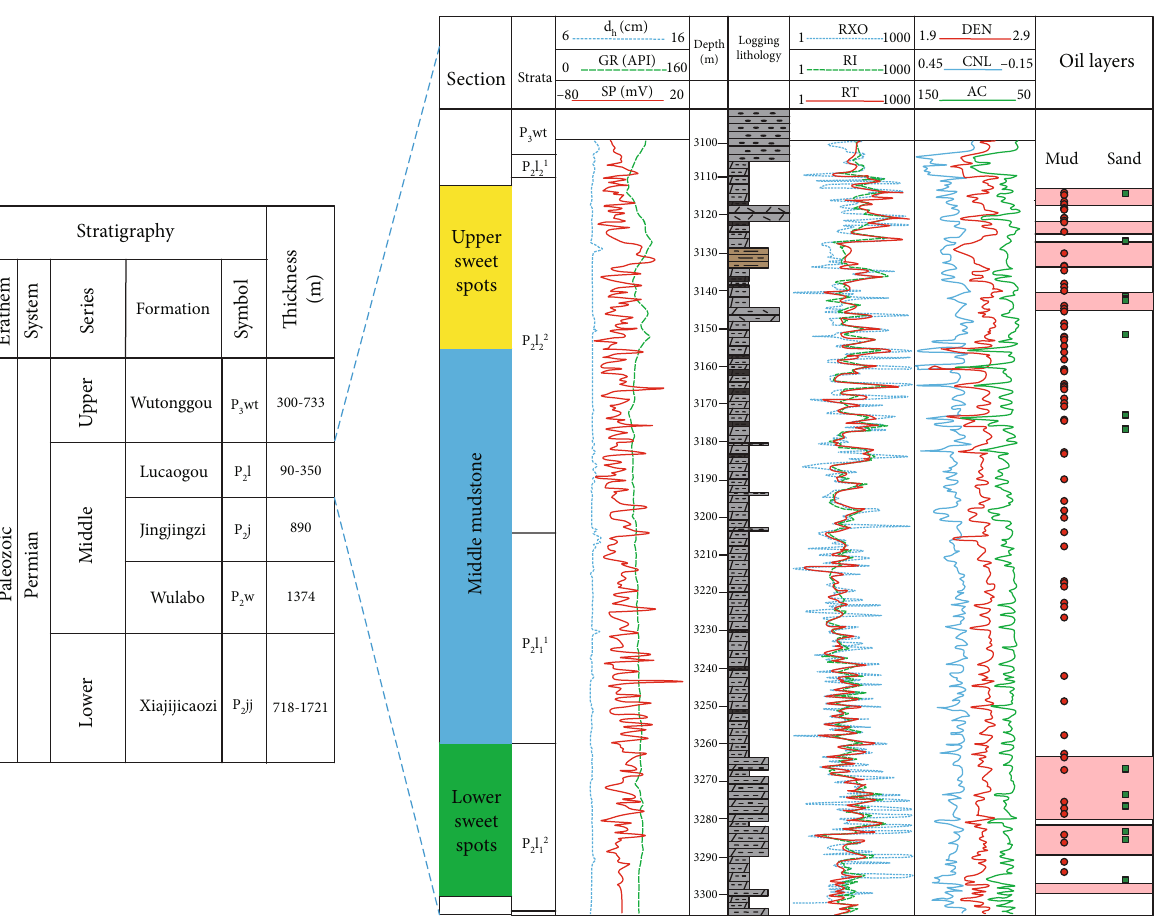
Figure 3: Generalized stratigraphy of the Jimusar sag and the lithology, porosity, and distribution of the two porous and permeable subsections (i.e., sweet spots), based on the representative Well Ji 174. CALI: caliper; GR: gamma ray; SP: spontaneous potential; DEN: density; AC: interval transit time; RT: formation resistivity; RI: resistivity of the intrusion zone; P Formation; P l 11 : upper part of the lower Lucaogou Formation; P 2 the upper Lucaogou